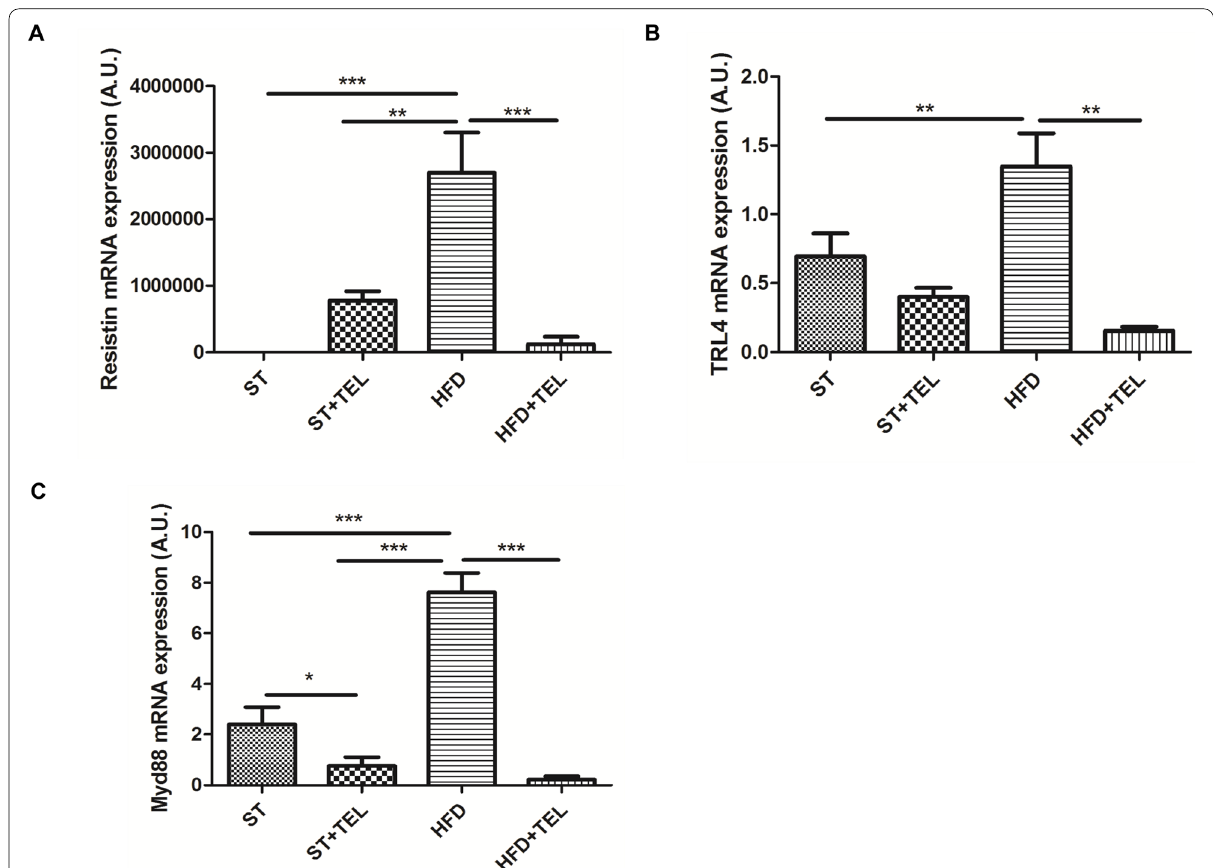
Fig. 5 Liver resistin/toll like-4 (TRL-4) and myeloid differentiation primary response 88 (Myd88) mRNA expression performed by qRT-PCR analyses ( a , b , c ). Data are presented as the mean SEM; * p <0.05, ** p <0.01, and *** p <0.001 versus the group ±